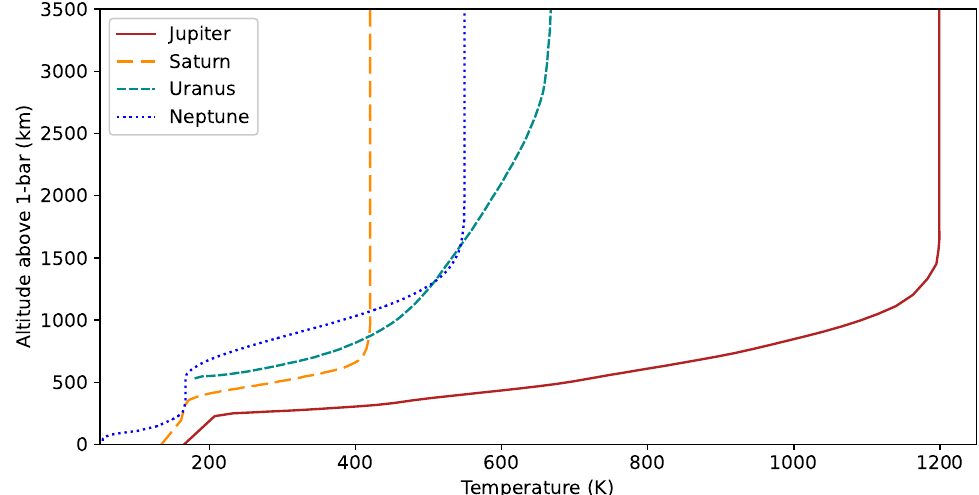
Figure 3. Models of neutral upper atmosphere temperatures for the giant planets Jupiter, Saturn [21], Uranus [17] and Neptune [18] as a function of altitude above the 1-bar pressure surfaces. The simulations of the upper atmospheres of Jupiter and Saturn include auroral heating. Temperatures in planetary upper atmospheres are highly variable temporally and spatially, so as with Figure 2, care must be taken when comparing temperatures between the planets, as we shall see in the proceeding sections. In other words, these values may be taken as broad